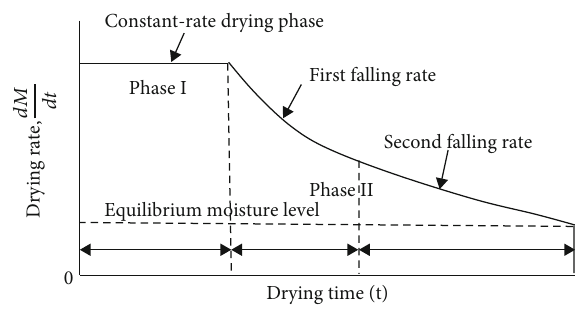
Figure 1: Drying rate curve